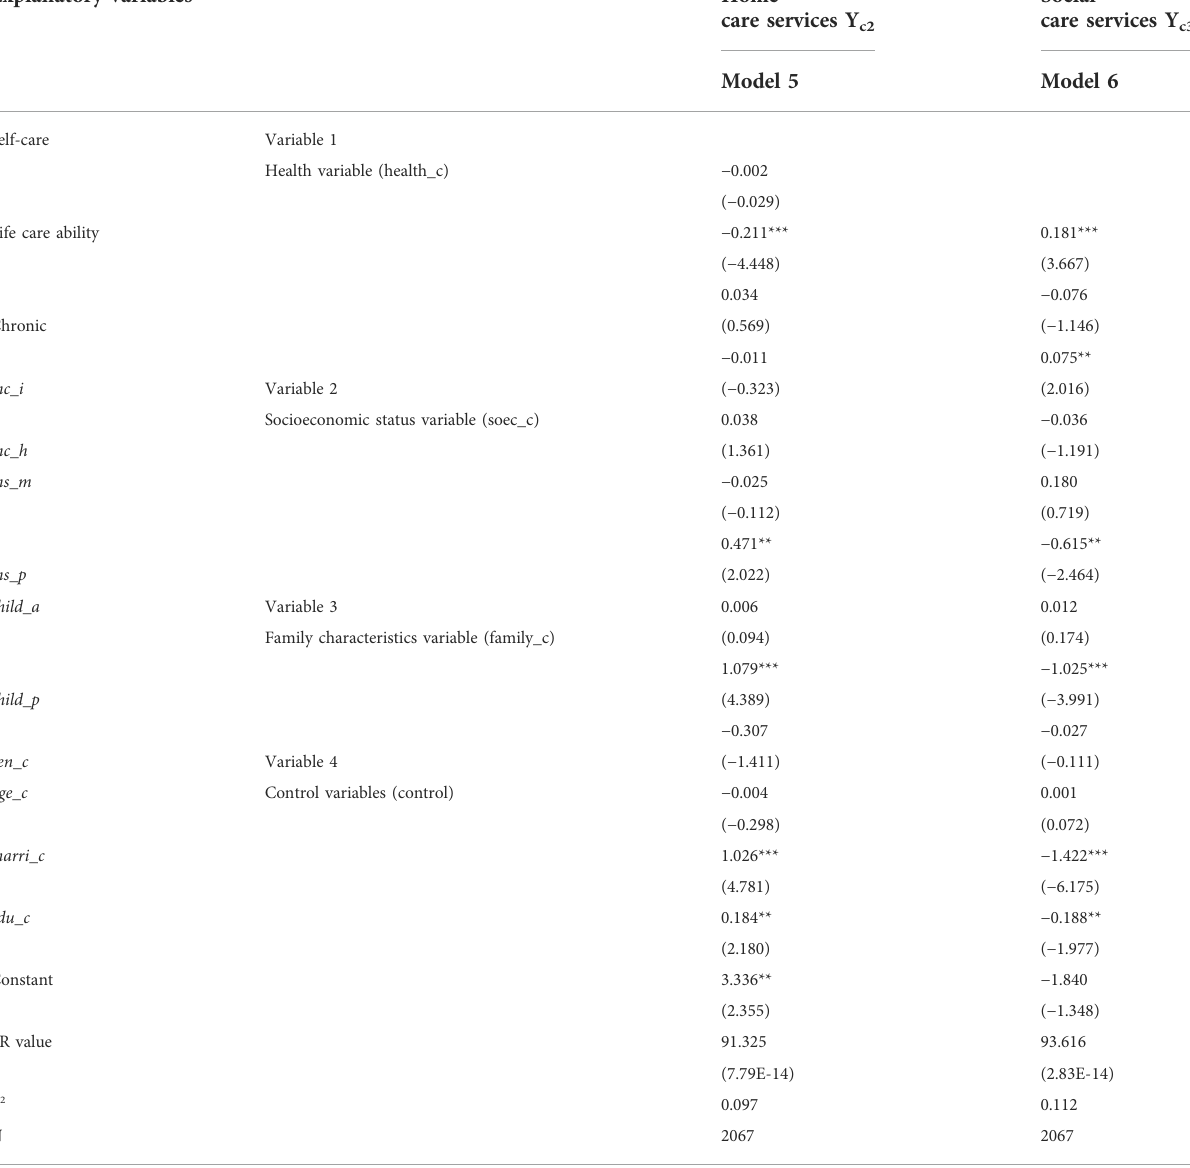
TABLE 3 Regression results of the rural elderly get the main types of old-age service